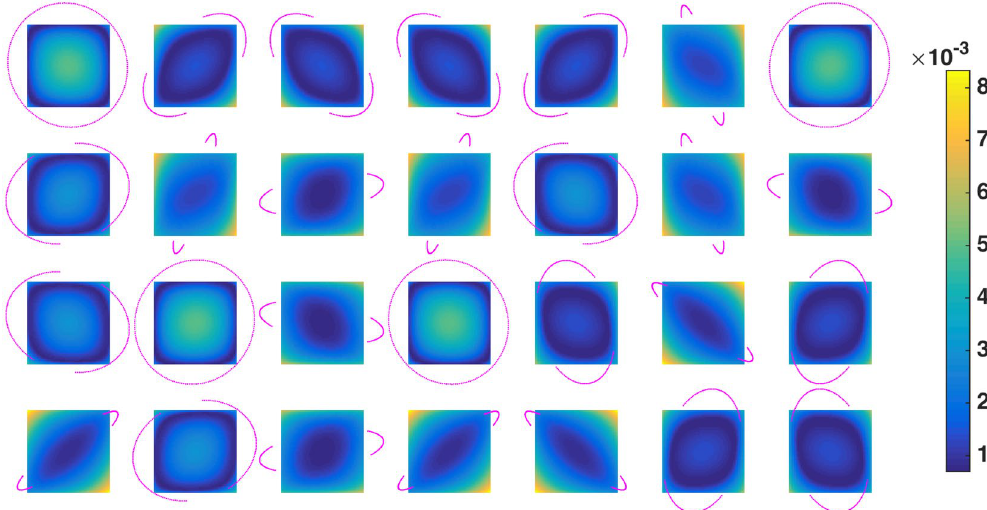
Figure 5. Null space components for each of the 28 points in Fig. 3(a) calculated using the acquisition scheme Z D (100) (Fig. 3(c)). The magenta points show the trajectories for each component truncated for maximum reachable | ψ | = 40° and the correponding images show the null space averaged over all x − z